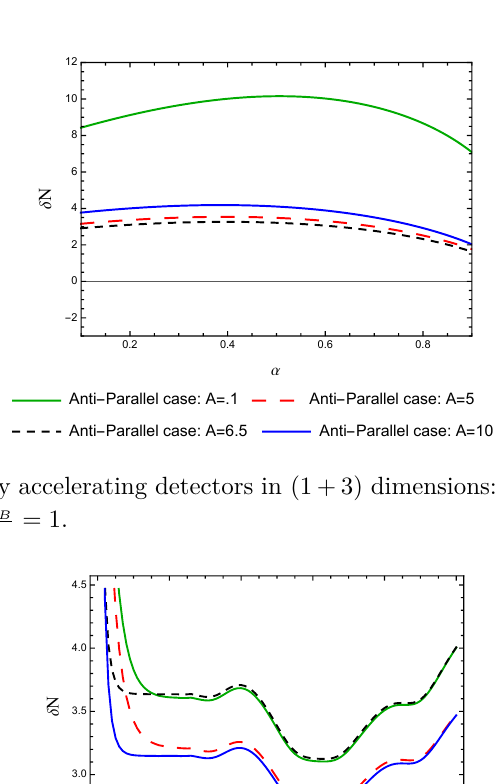
entanglement. This is studied by plotting δ N as a function of α in figure 11 for different fixed A . For fixed a A the degradation first increases and then after a certain α , it decreases. The nature obtained is similar to that in the parallel